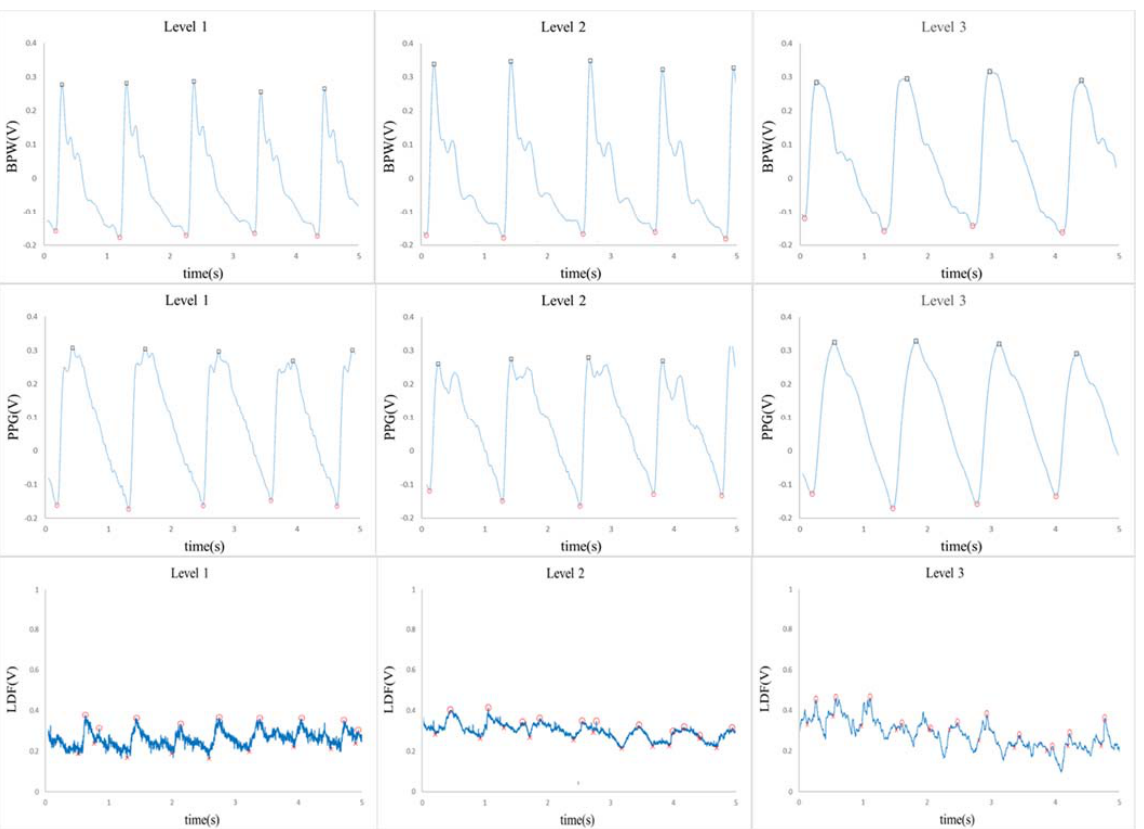
Figure 2. Typical time-domain waveforms. Before the measurements, the subjects were relaxed and rested for at least 10 min. The environmental temperature was within 23–25 °C during the entire measuring period.